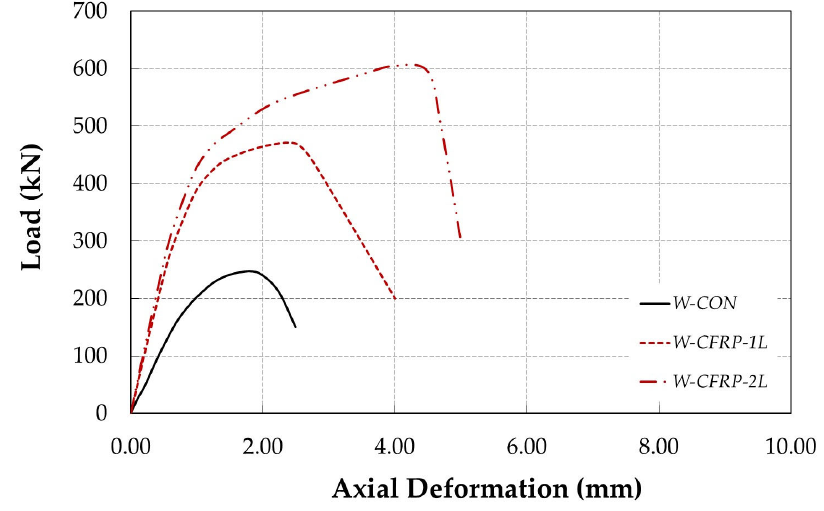
Figure 7. Axial Load versus axial deflection responses (control and CFRP walls).